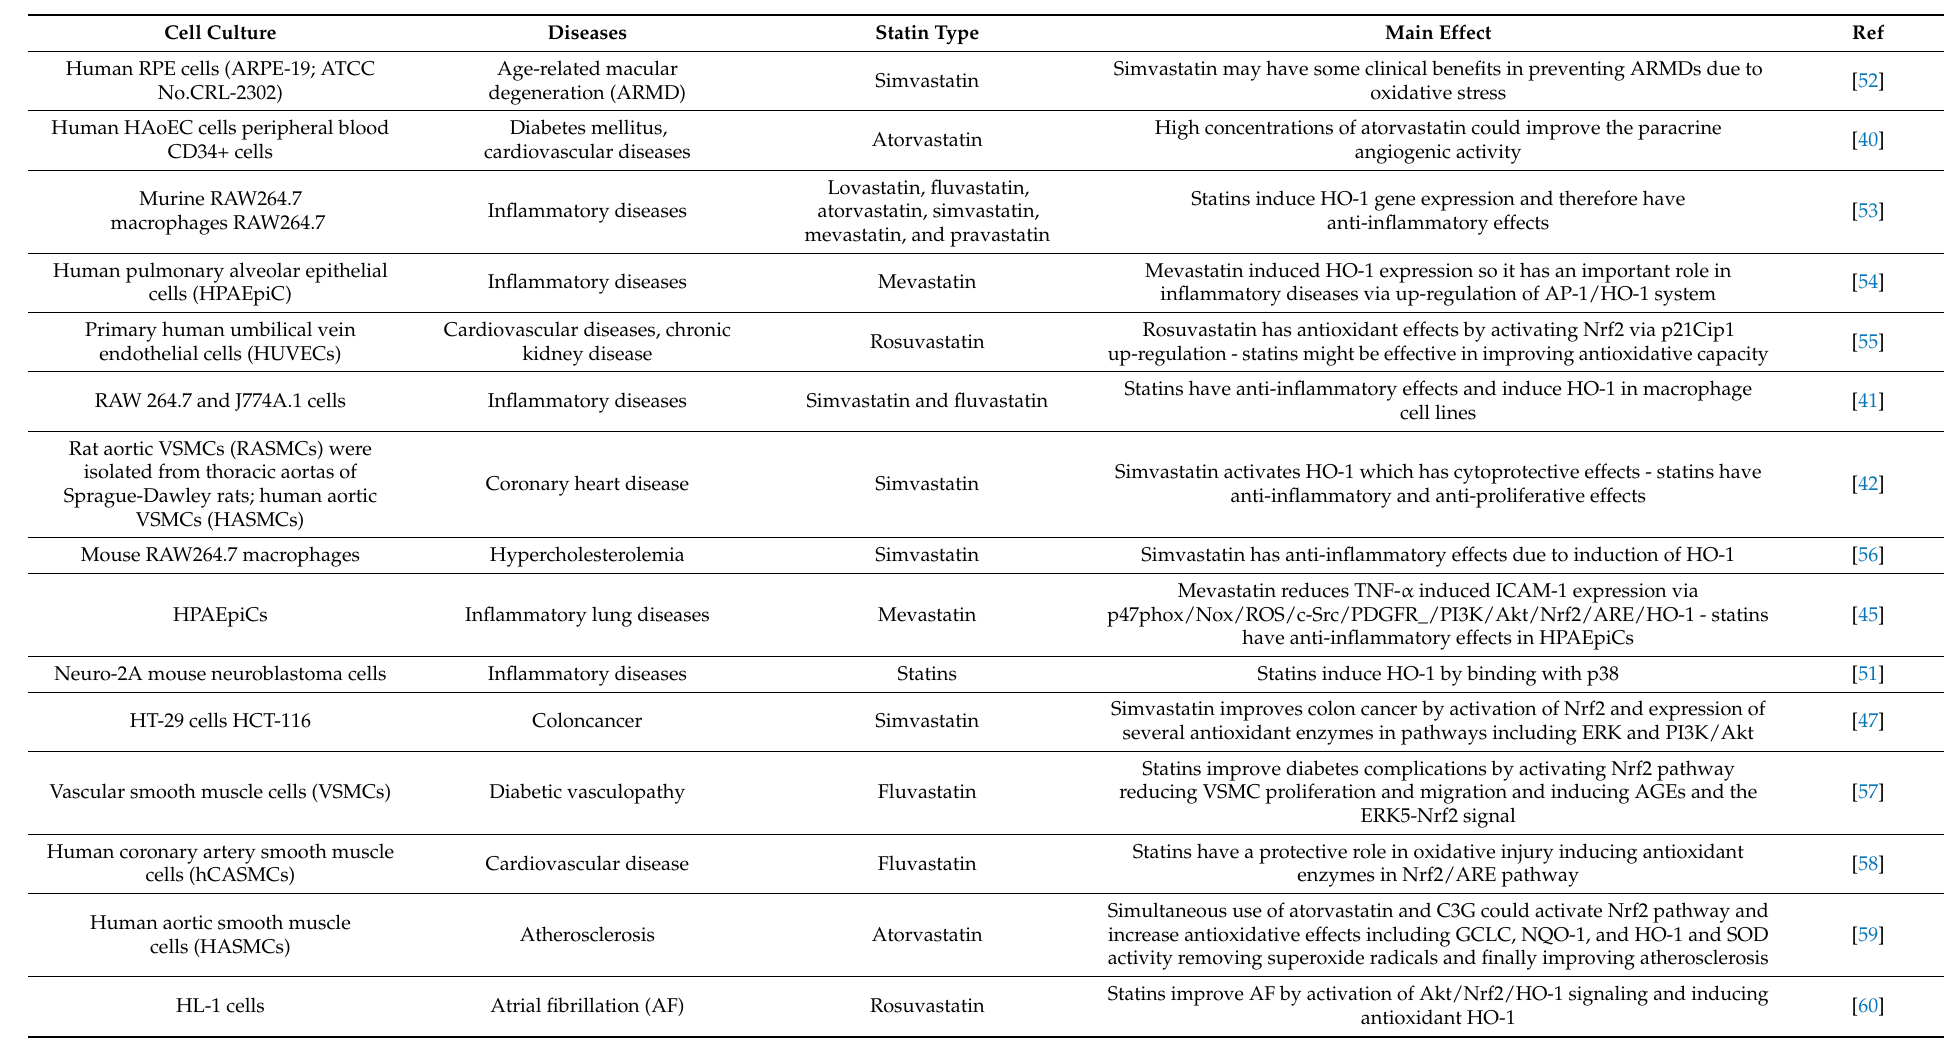
Table 2. Summary of in vitro studies investigating statin effect in various